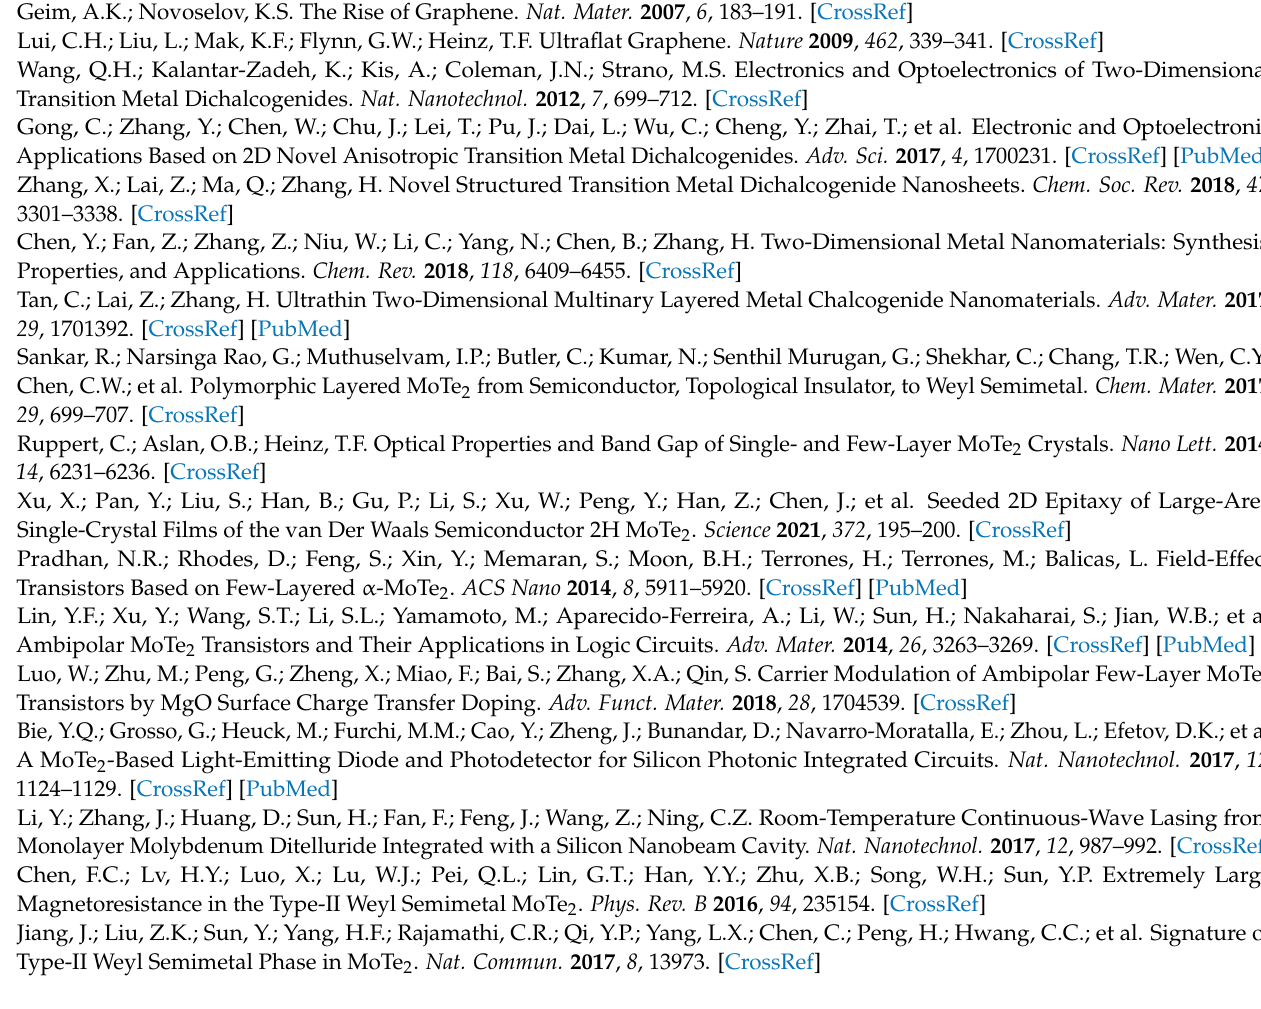
Figure S7: (a–b) SEM image and Energy Dispersive Spectroscopy of the nanoparticles related to Na 2 MoO 4 ; Figure S8. Atomic structures used in the DFT